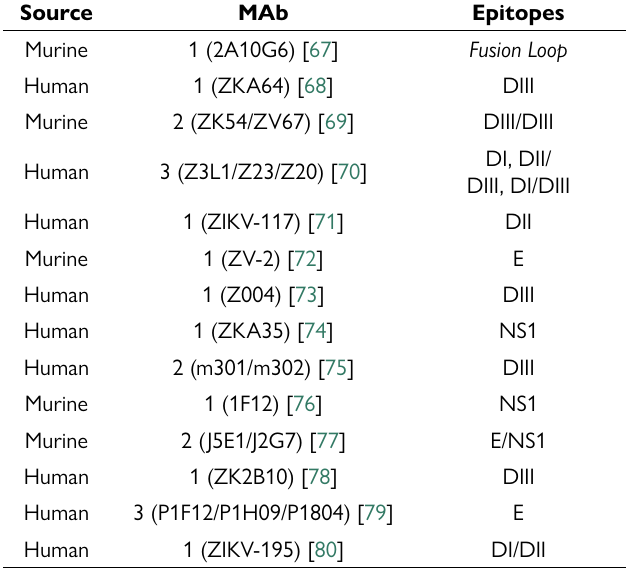
Table 2. Main monoclonal antibodies against ZIKV.